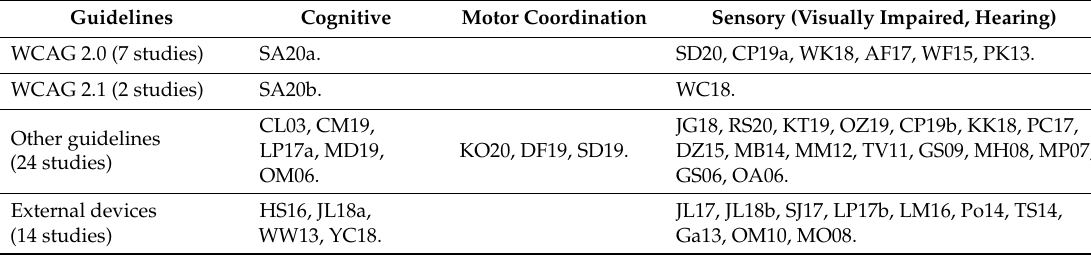
Table 6. Guidelines by